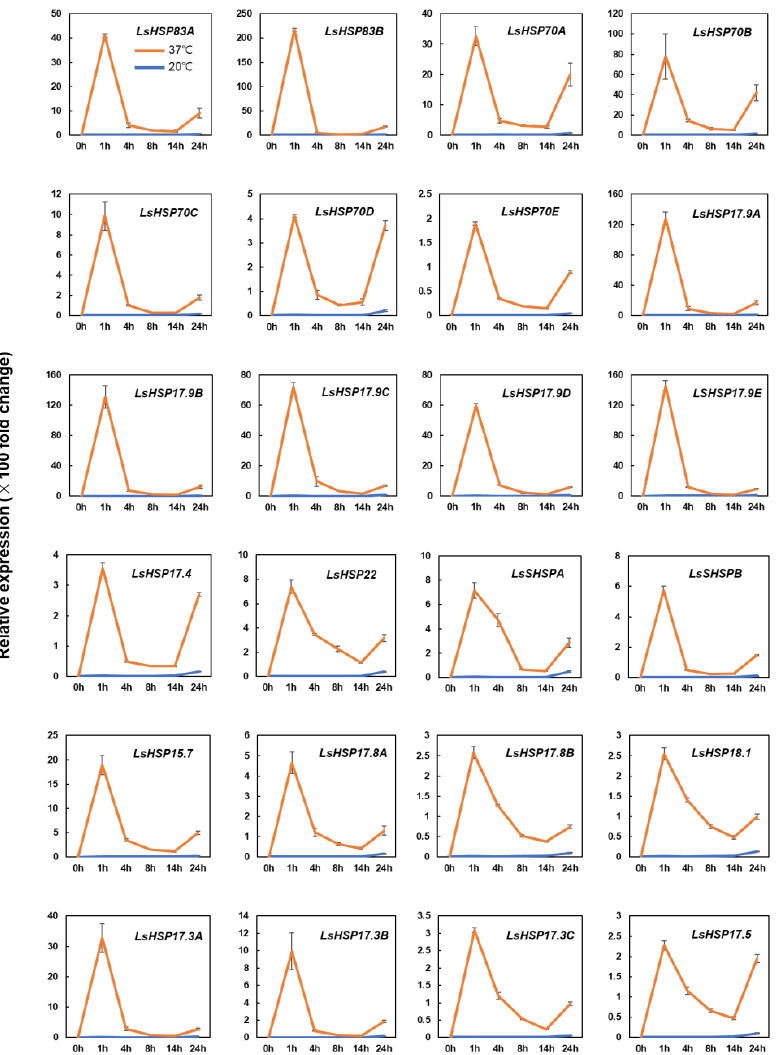
Figure 4. Relative expression level of heat shock protein genes at different time points under heat stress. Alterations in e xpression levels of lettuce heat shock protein genes with (37 °C) and without (20 °C) heat treatment for 24 h. The expression levels of LsHSP genes are higher in lettuce plants with heat treatment at all the time points examined, compared to control ( p < 0.05, Student’s t test). Each bar represents mean ± SE of three independent experiments.